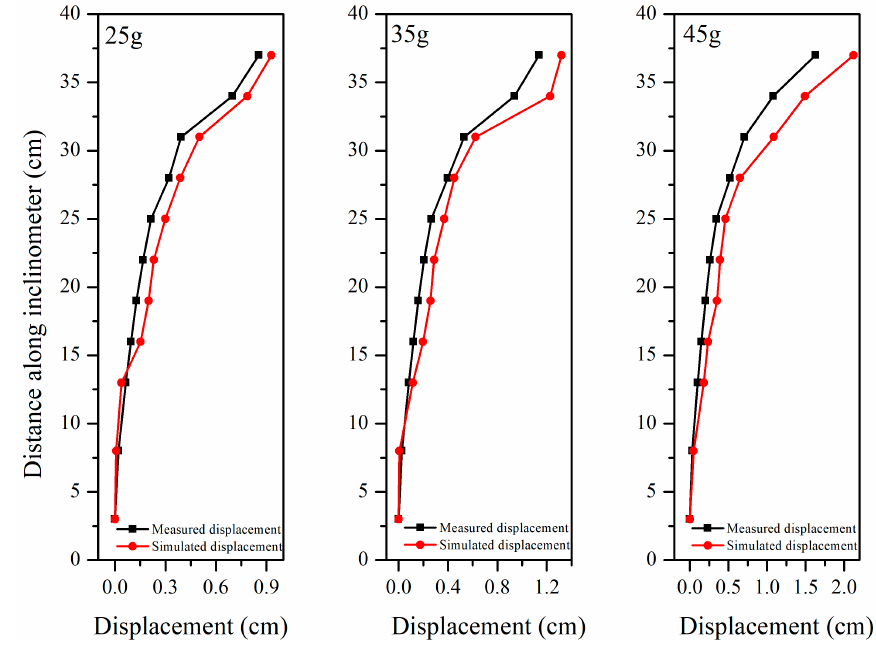
Figure 14. Comparison of the displacement obtained by the FBG-based inclinometer and simulation.